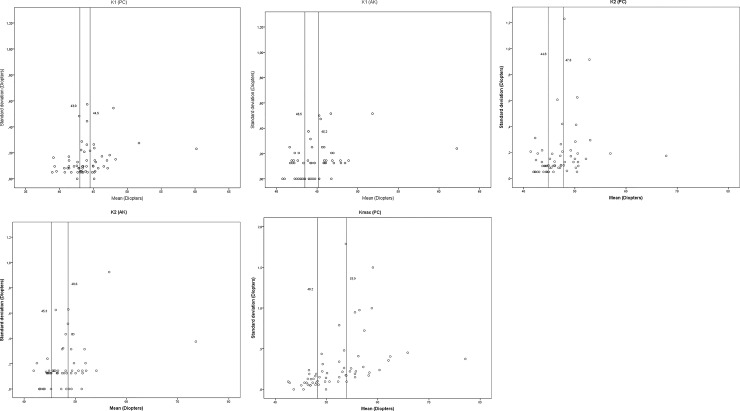
Mean values of the flattest central keratometry value (K1) obtained with the PC (a), and the AK (b), the steepest keratometry value (K2) obtained with the PC (c), and the AK (d), and the maximum keratometry value (Kmax), plotted against the standard deviation (e). The reference lines indicate the division into groups according to Table 1.